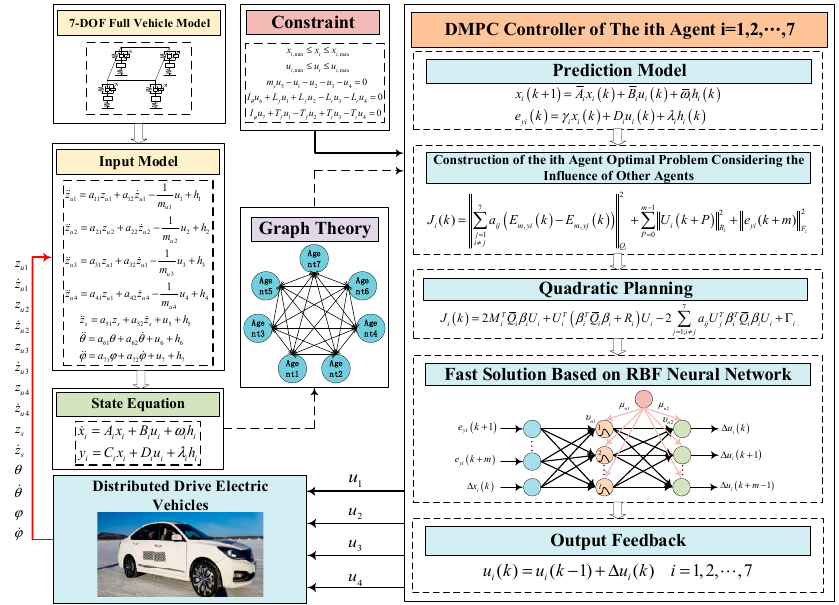
Figure 1. Overall framework of the paper.